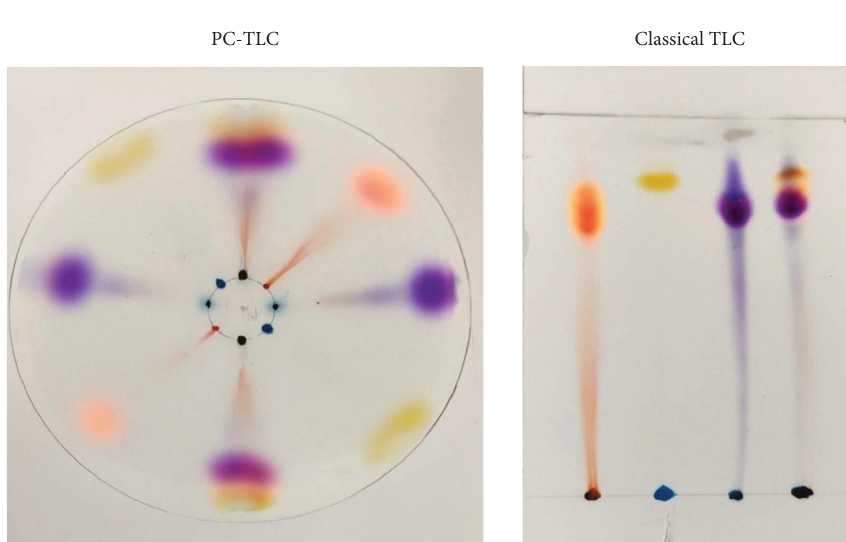
Figure 4: Ballpoint ink separation by classical and pressurized